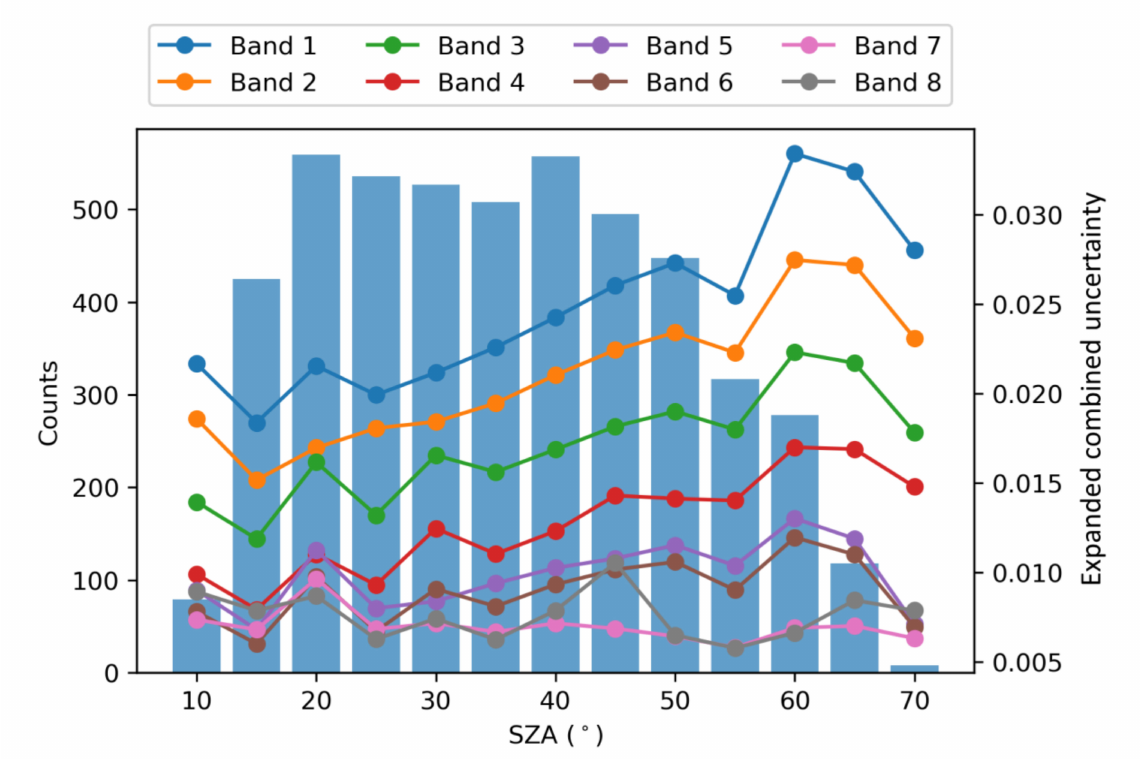
Figure 9. Total combined uncertainty in LSR according to SZA for eight GOCI spectral bands (colored solid line with circle symbol). The blue bar plot indicates the data count used in each